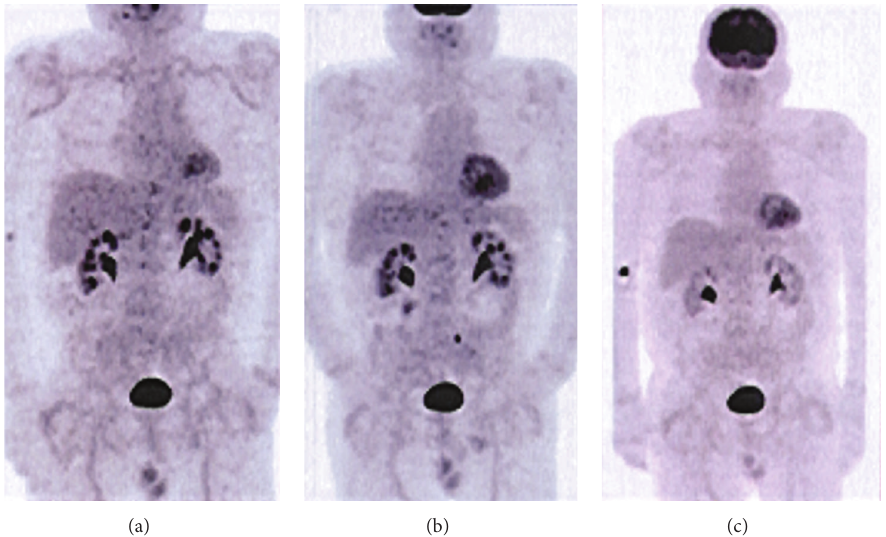
Figure 3: Sequential PET scan images. (a) One-year follow-up: medium intensity uptake of 18F-FDG at the subclavian, carotid, and femoral arteries.(b)Two-yearfollow-up:mediumintensityuptakeof18F-FDGatthefemoralandrightexternaliliac.(c)Three-yearfollow-up:absence of 18F-FDG uptake. PET: positron emission tomography. 18F-FDG: